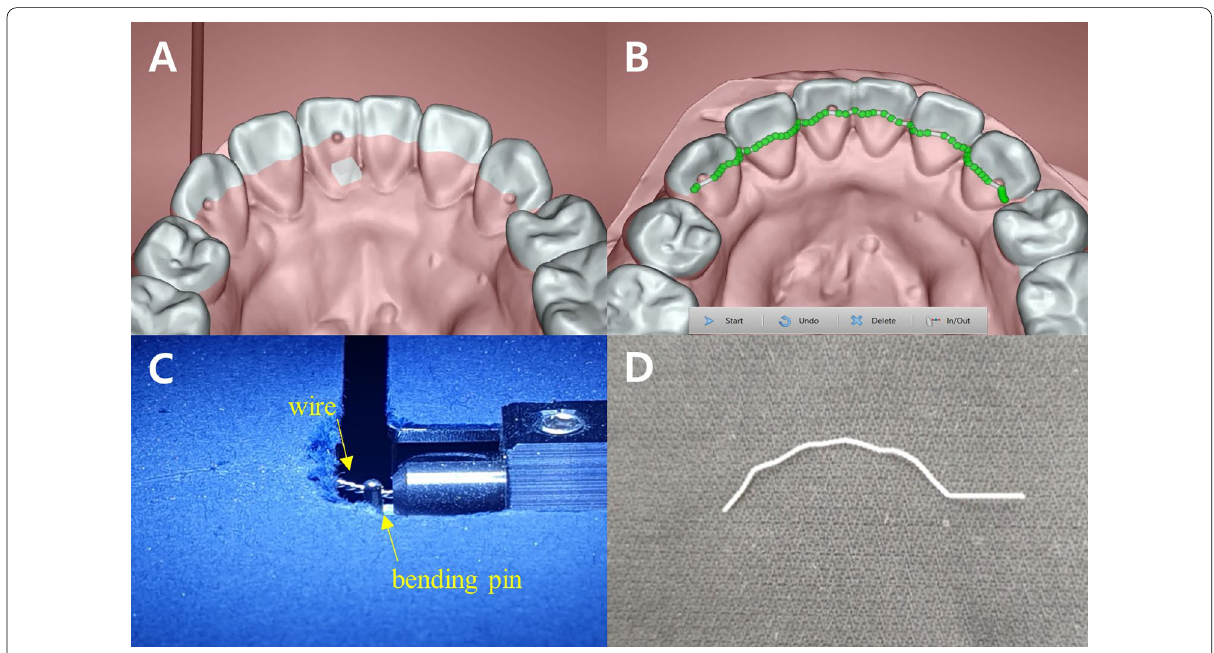
Fig. 3 Fabrication of custom‑bent type lingual fixed retainer. A Plane setting based on small dimples of dental model. B Design of retainer on reference plane (bypassed small dimples). C Bending process of wire. D Final